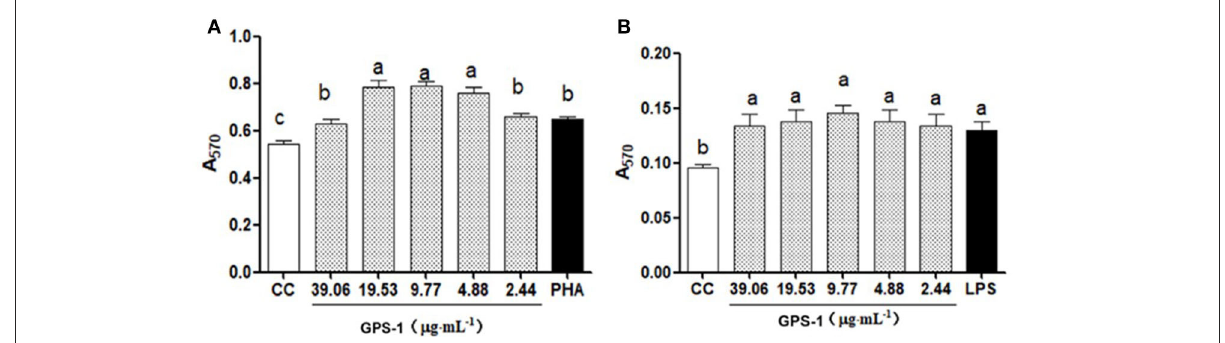
FIGURE1 Effects of GPS-1 on A570 of chicken peripheral (A) and spleen lymphocytes (B) . a − c Values in the same column with different superscript letters differ significantly at p < 0.05.